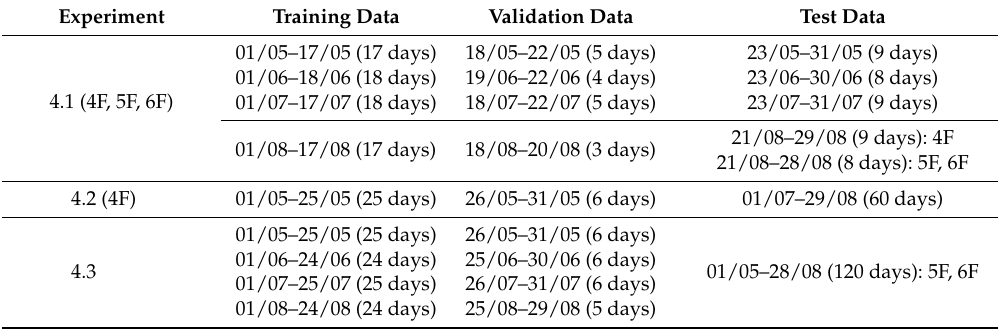
Table 3. Training, validation and test data period for each